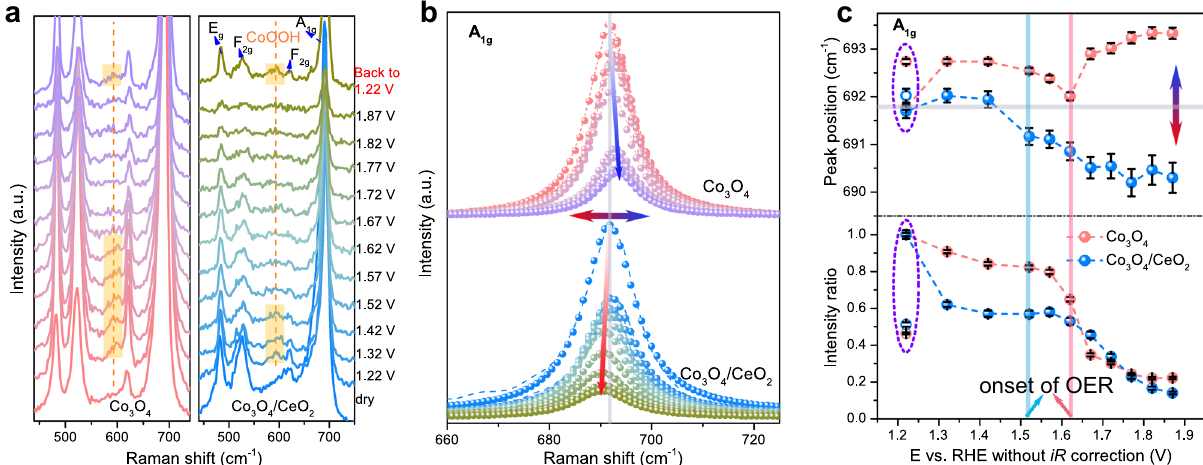
Fig. 5 In situ Raman characterizations of Co 3 O 4 and Co 3 O 4 /CeO 2 catalysts on carbon paper electrodes during OER testing in 0.5 M H 2 SO 4 solution to reveal the structural evolution of catalysts. a The in situ Raman spectra of Co 3 O 4 (left panel) and Co 3 O 4 /CeO 2 (right panel) at various constant potentials (vs. RHE) without iR correction (increased from 1.22 to 1.87 V and then back to 1.22 V). The Raman spectra of the dry samples were also presented at the bottom for comparisons. b The Raman A 1g peaks of Co 3 O 4 (top) and Co 3 O 4 /CeO 2 (bottom) were fi tted with Lorentzian function to extract the peak positions, intensity, and FWHM (dash lines: raw spectra; dots: fi tting results). c The Raman A 1g peak positions (upper panel) and intensity ratio with respect to the initial intensity at 1.22 V (lower panel) plotted against the applied potential. The open symbols represent the data collected at 1.22 V at the end after applying the higher potential sequence. The error bar represents the error from fi